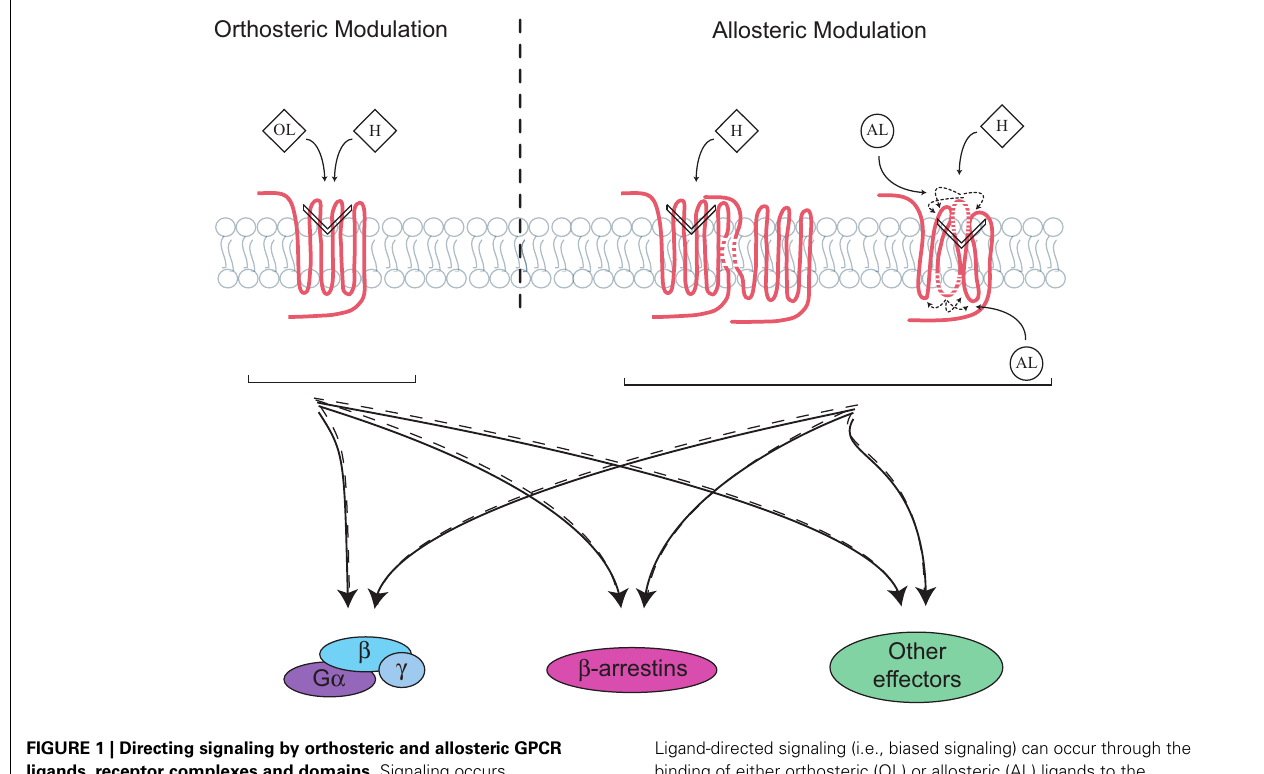
FIGURE 1 | Directing signaling by orthosteric and allosteric GPCR ligands, receptor complexes and domains . Signaling occurs following the binding of endogenous hormones (H) to the orthosteric site on G protein-coupled receptor (GPCR), which involves different domains, mainly the transmembrane and extracellular ones.This leads to the activation of multiple signaling pathways that are balanced between the G proteins, β -arrestins, and/or other signaling